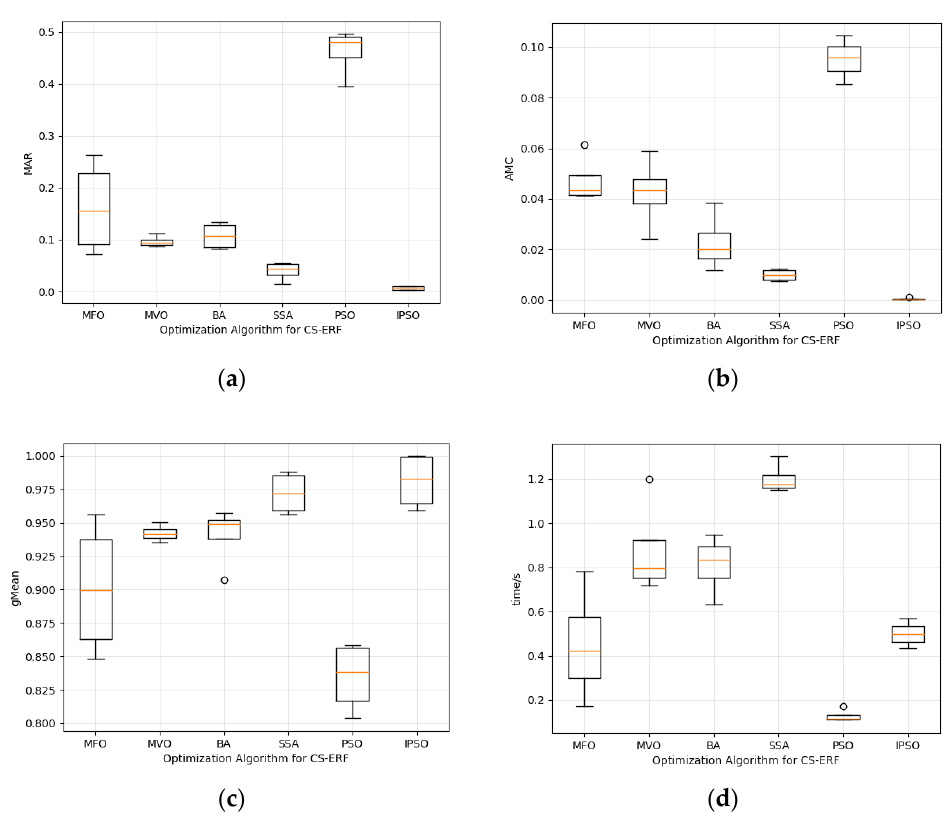
Figure 6. ( a ) Comparison of the MAR of the six algorithms; ( b ) comparison of the AMC of the six algorithms; ( c ) comparison of the gMean values of the six algorithms; ( d ) comparison of the time used to run the six algorithms.